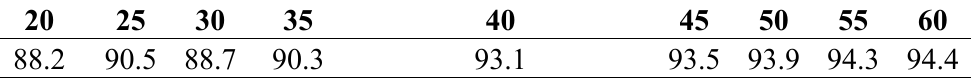
Table 2. RBRC retrieval rate (%) for different parameters N